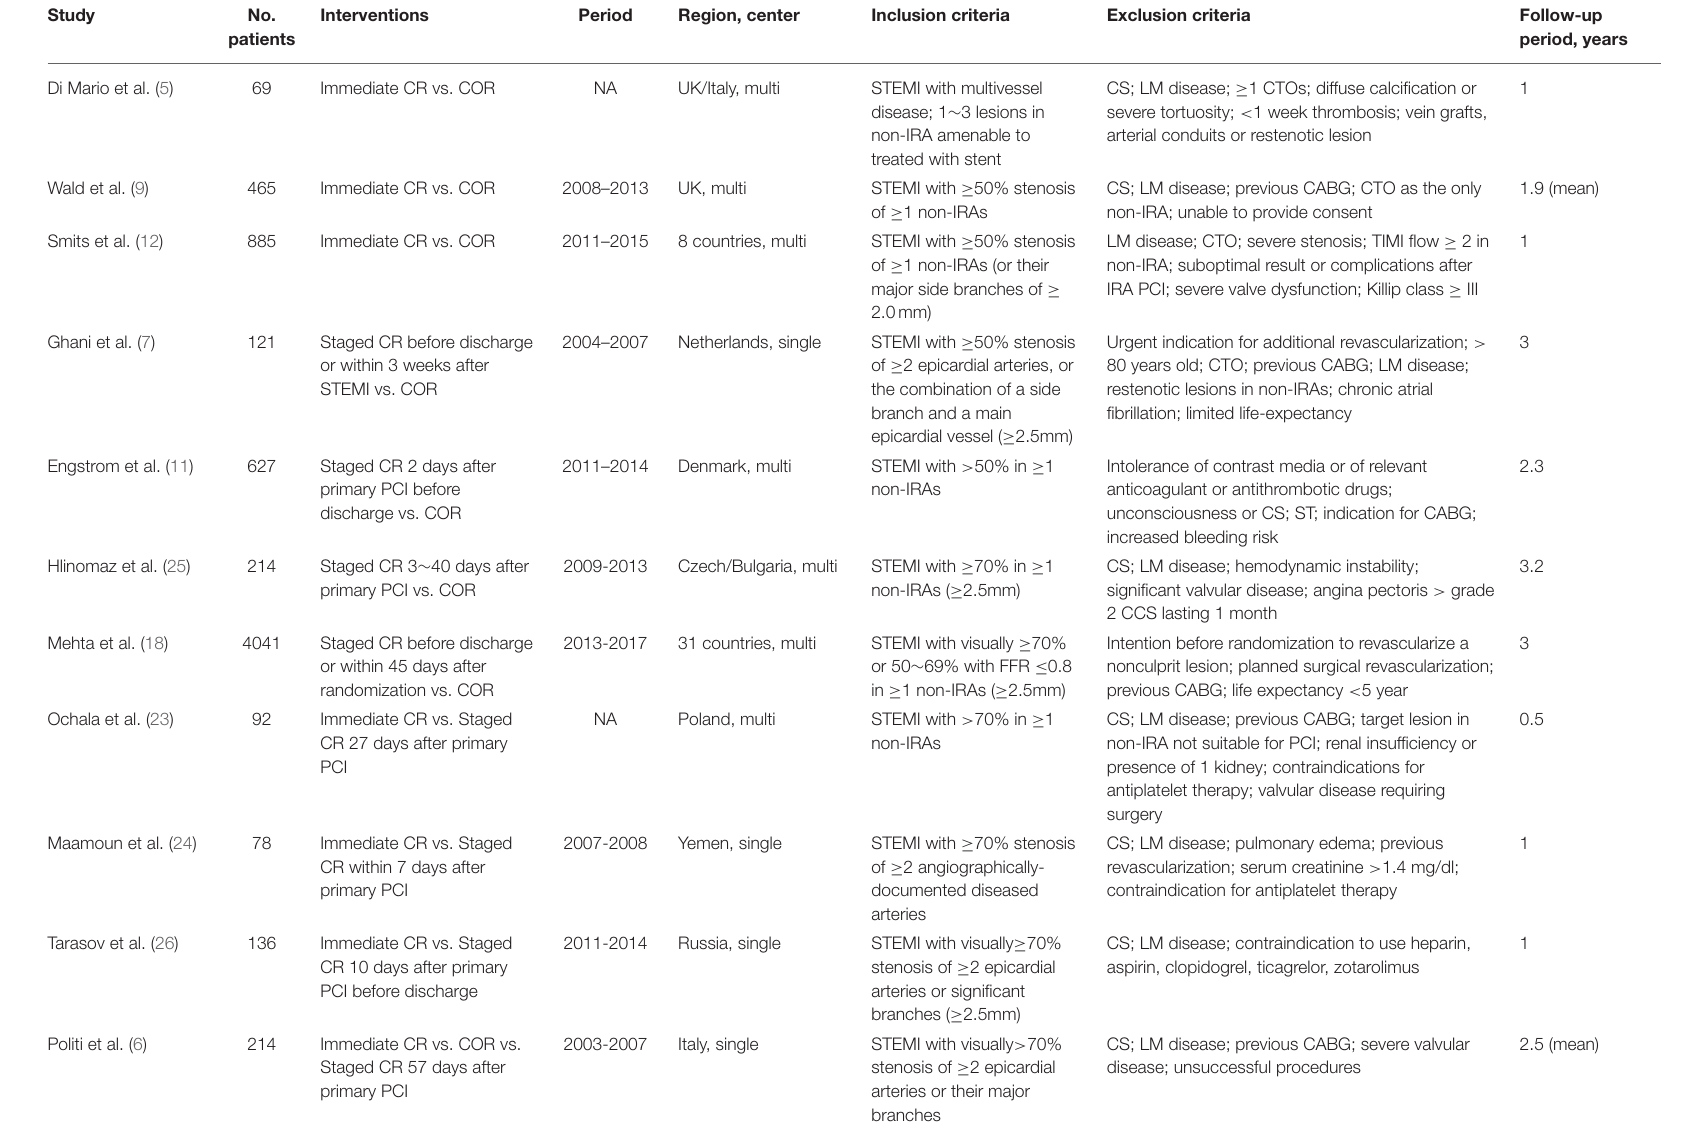
TABLE 1 | Main characteristics of the eligible